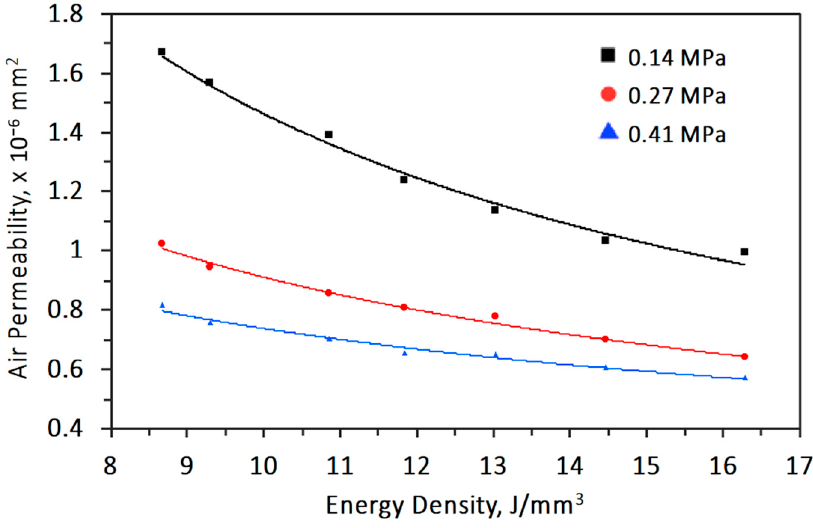
Figure 10. Relationship between air permeability and energy density for 4 mm thickness coupons tested at different inlet pressures.